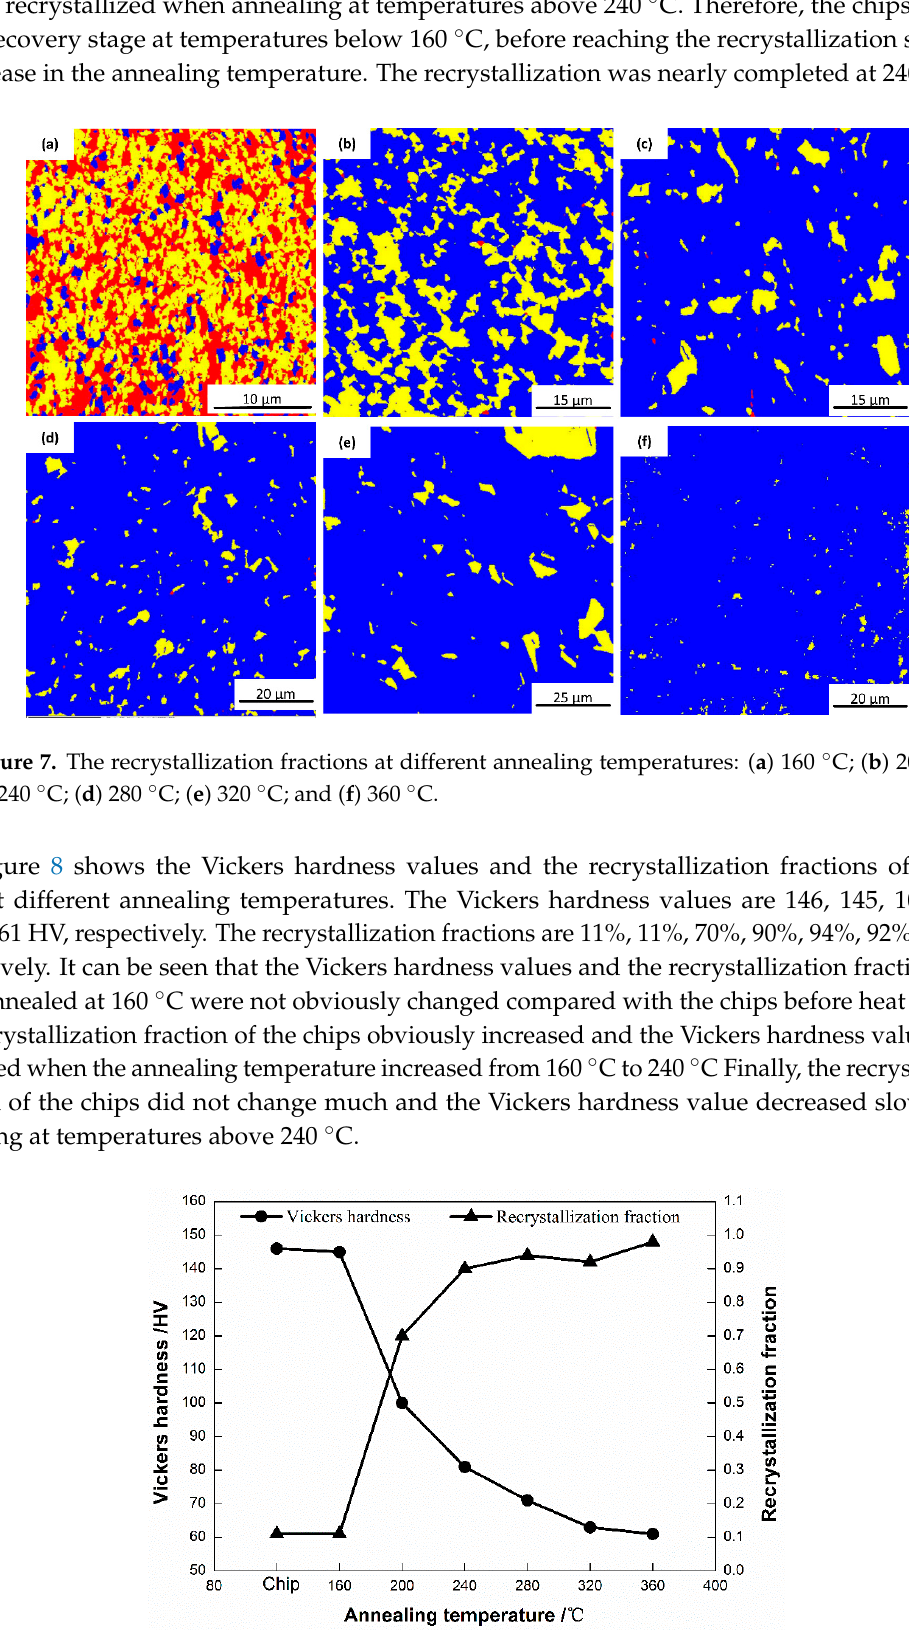
Figure 8. Vickers hardness values and recrystallization fractions at different annealing temperatures.